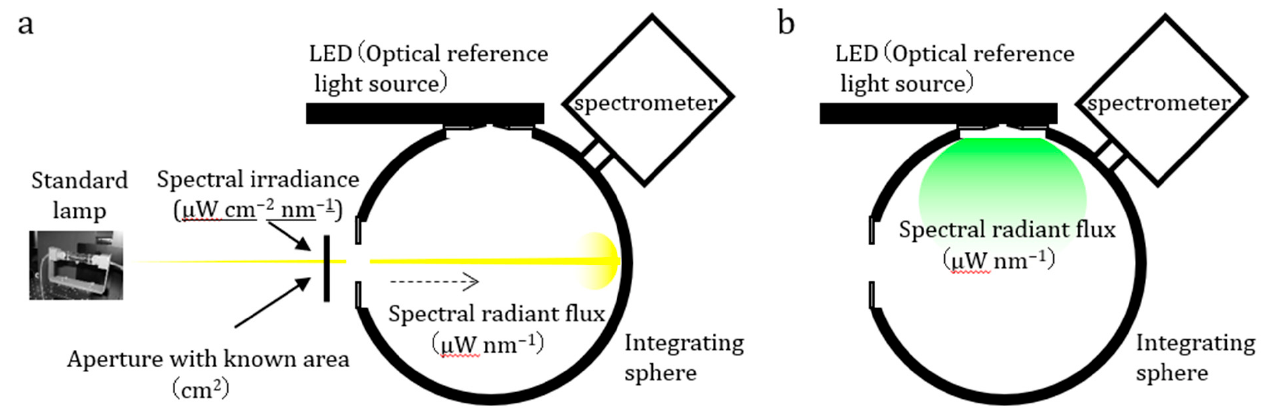
Figure 2. Integrating sphere equipped with a spectrometer to measure the absolute optical signal value of LED-based optical reference light sources. ( a ) Calibration of the absolute sensitivity of the apparatus based on a standard lamp whose spectral irradiance value ( µ W cm − 2 nm − 1 ) and aperture area (cm 2 ) are known. ( b ) Measurement of spectral radiant flux ( µ W nm − 1 ) of LED-based optical reference light source where wavelength integration of spectral radiant flux ( µ W nm − 1 ) gives radiant flux ( µ W).